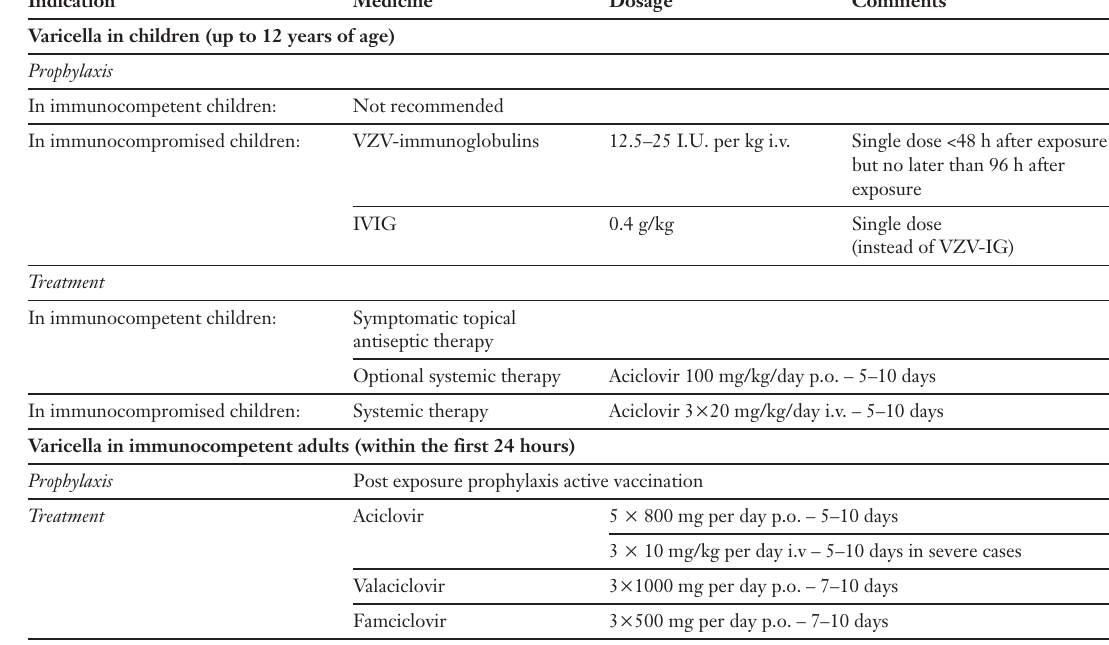
Post-exposure pro- phylaxis and antiviral treatment of